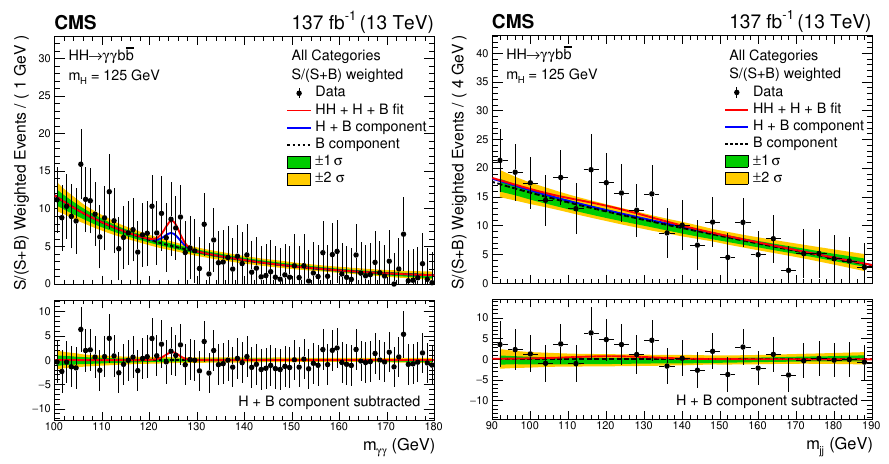
(left) and m (right) for the selected events in data Figure 9 . Invariant mass distributions m γγ jj (black points) weighted by S/(S+B), where S (B) is the number of signal (background) events extracted from the signal-plus-background fit. The solid red line shows the sum of the fitted signal and background (HH+H+B), the solid blue line shows the background component from the single Higgs boson and the nonresonant processes (H+B), and the dashed black line shows the nonresonant background component (B). The normalization of each component (HH, H, B) is extracted from the combined fit to the data in all analysis categories. The one (green) and two (yellow) standard deviation bands include the uncertainties in the background component of the fit. The lower panel in each plot shows the residual signal yield after the background (H+B) subtraction.